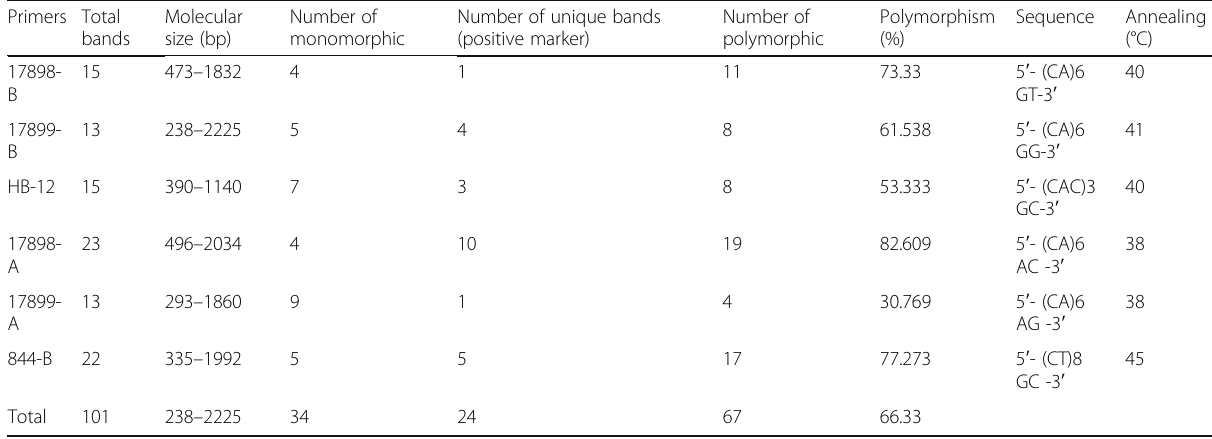
Table 16 Band variation and polymorphism percentage in seven rice